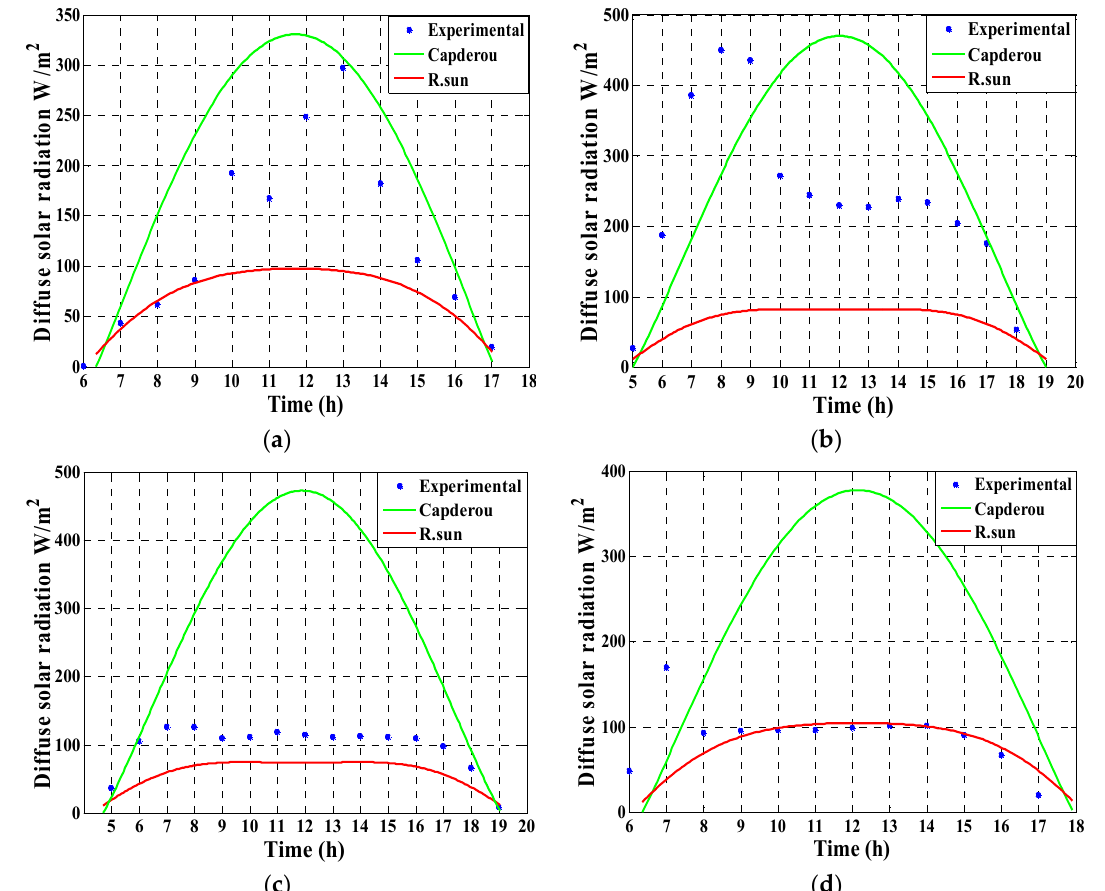
Figure 9. The comparison between the measured diffuse solar radiations and the diffuse solar radiation obtained by Capderou and R.Sun models for the site of Senia. ( a ) 16 February 2006; ( b ) 20 May 2006; ( c ) 1 July 2006; ( d ) 2 October 2006.